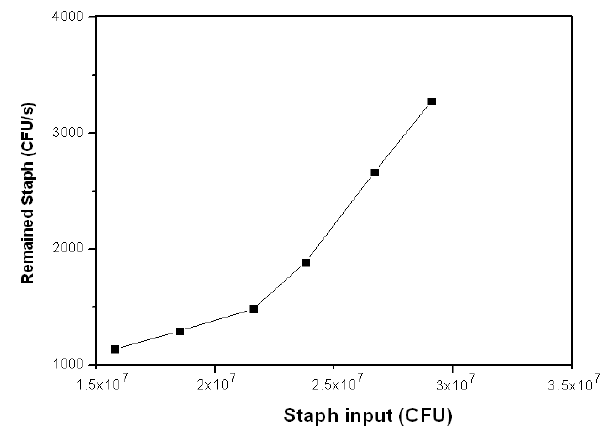
Figure 7. Remaining Staph at different input